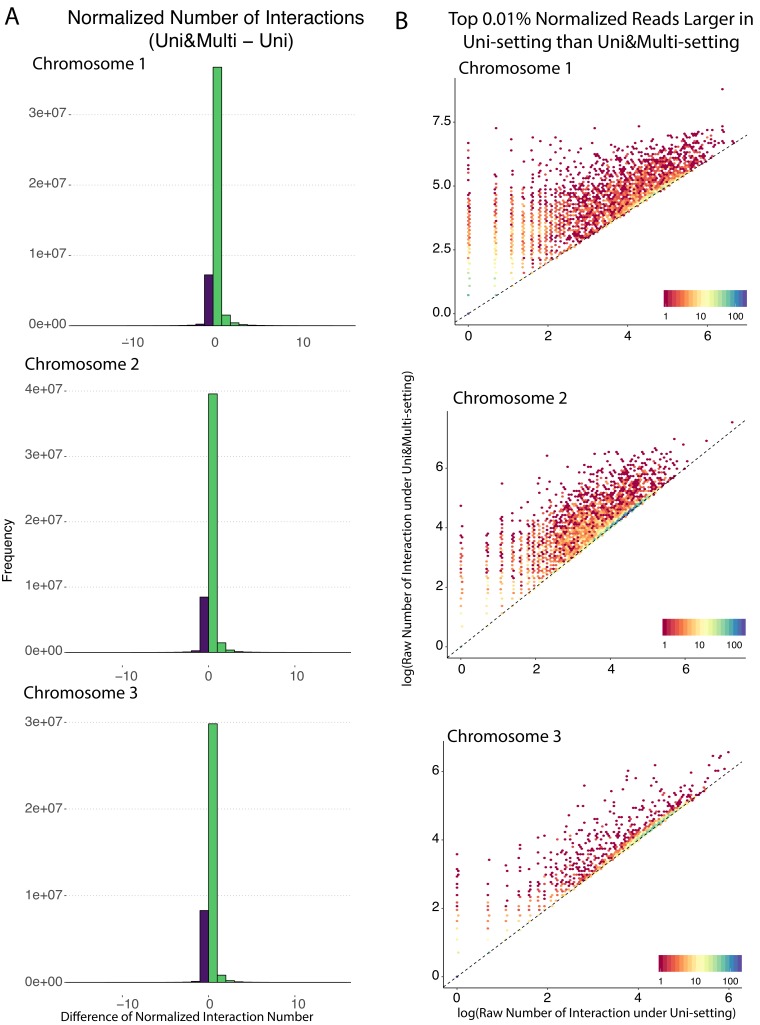
Bin coverage comparison of normalized contact matrices under Uni&Multi- and Uni-settings for GM12878 with combined reads from replicates 2–9 at 5 kb.(A) Histogram of the bin-level differences between normalized contact counts of the Uni&Multi- and Uni-settings. Green bars represent increased counts under the Uni&Multi-setting, and purple ones indicate no change or decrease. Bins in the purple bar group are low coverage bins under the Uni-setting and have inflated normalized contact counts. Only chromosome 1–3 are shown, and the pattern for the rest of the chromosomes are very similar. (B) Raw contact count comparison of the top 0.01% bins of Panel A with drastically higher normalized contact counts under the Uni-setting compared to the Uni&Multi-setting (purple bars). The contact counts of these bins get inflated by normalization. The dashed lines are y = x.